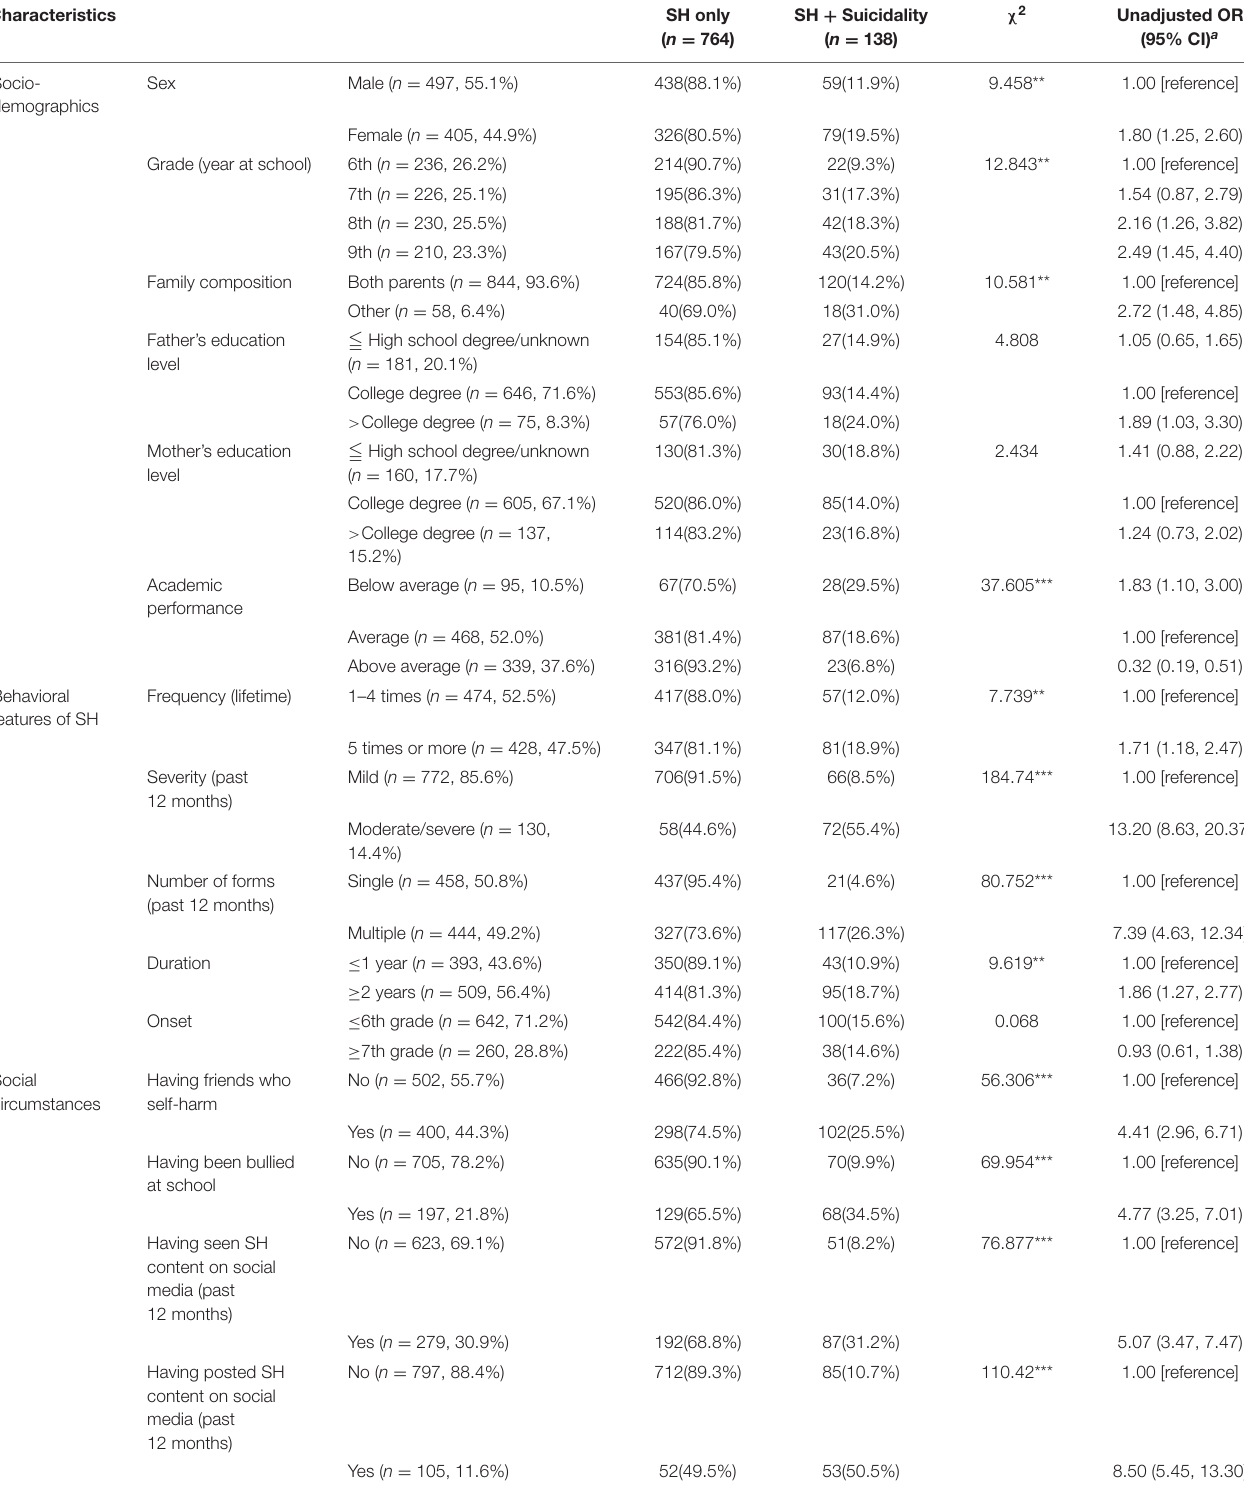
TABLE 1 | Sample characteristics and associations with lifetime suicidality ( n =